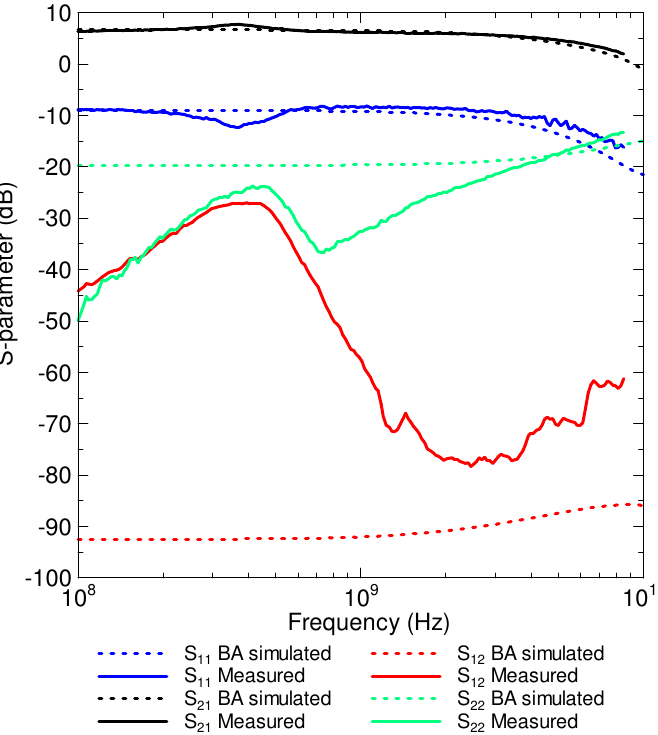
Figure A2. Comparison of simulated and measured single-ended input/output